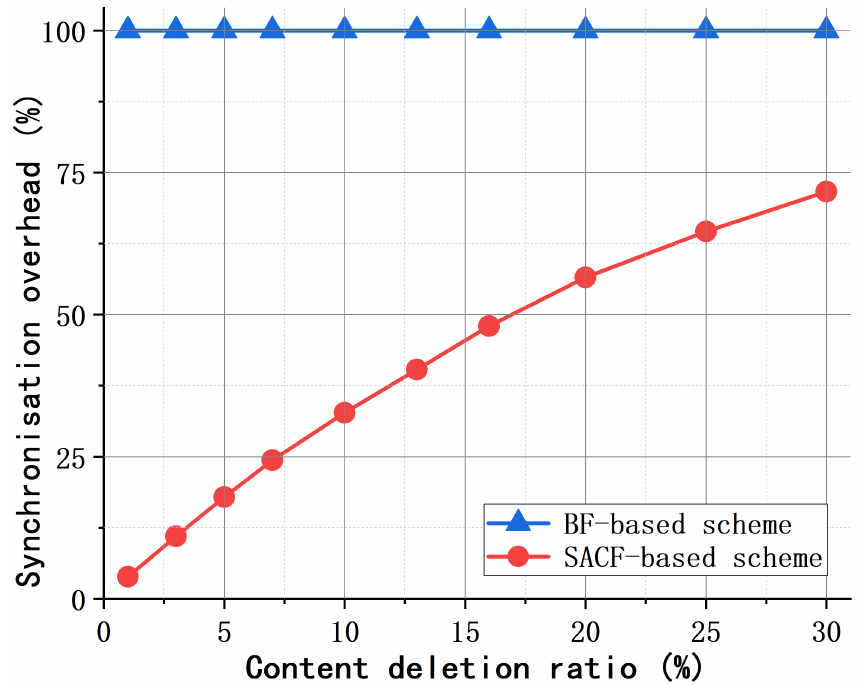
Figure 11. Synchronization overhead under varied deletion